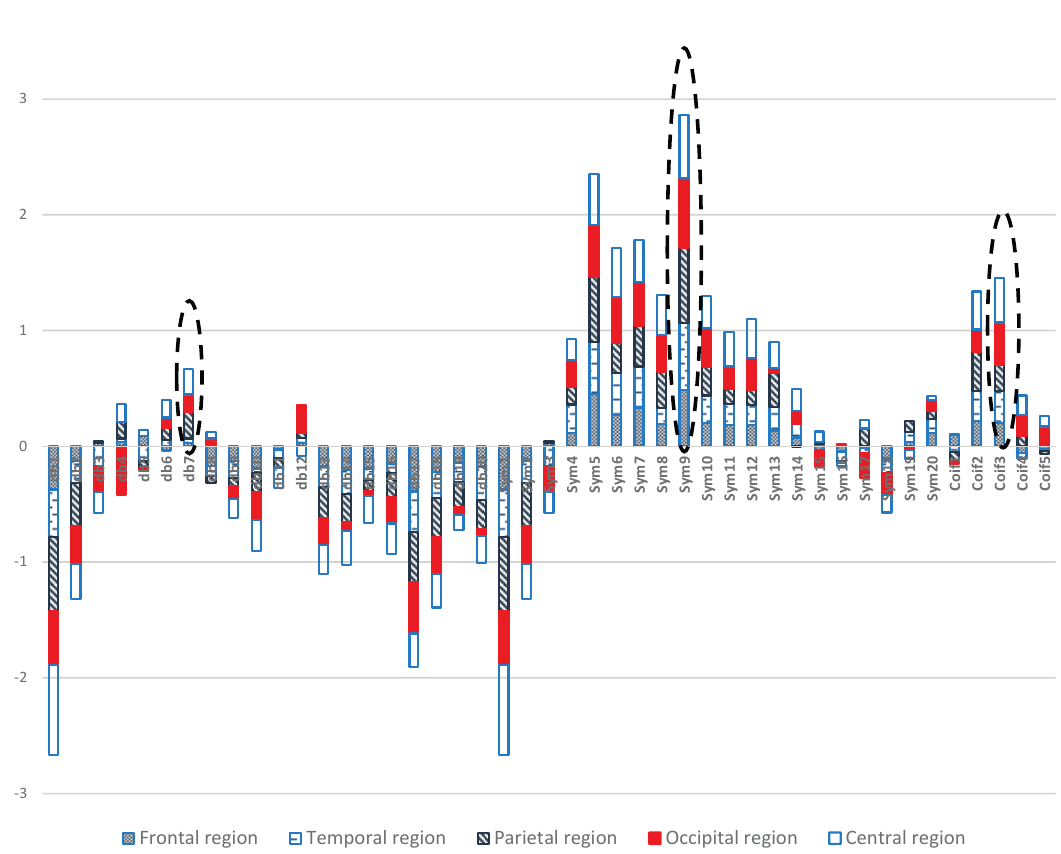
Figure 14. Comparative plot of the correlation coefficients with 45 mother wavelet filter for the 5 regions of the brain for 10 control